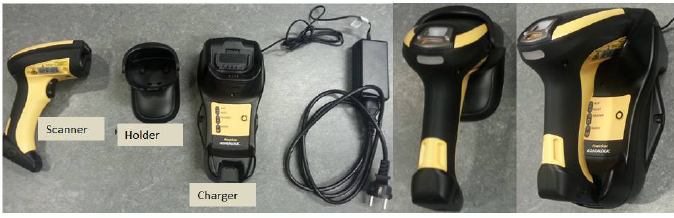
Figure 5. Power TM 9500 scanner with its components.